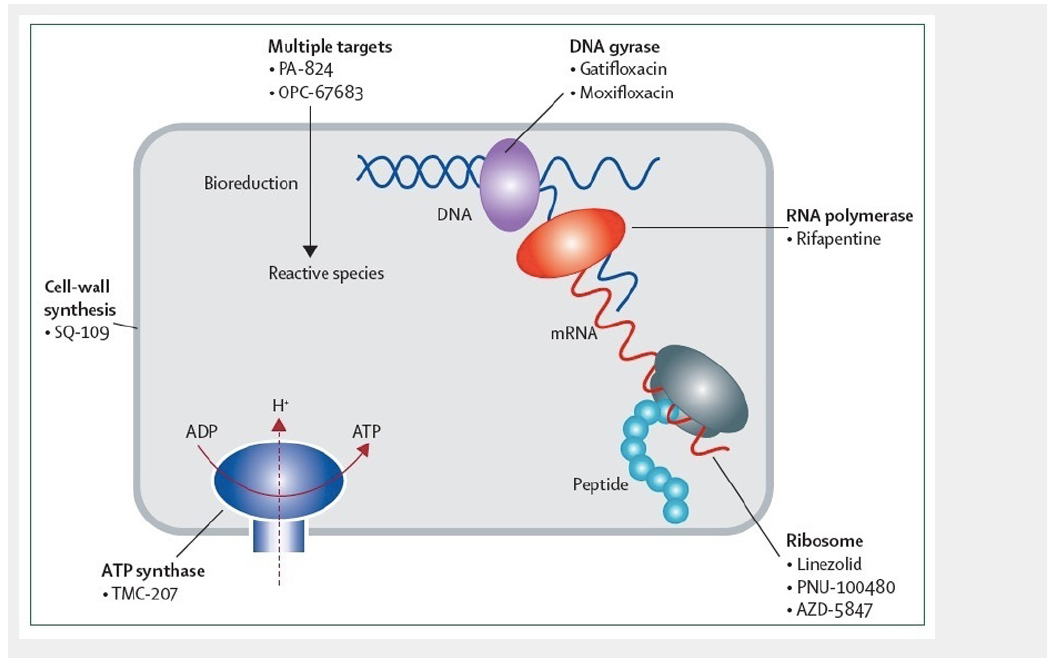
Mechanisms of action of new compounds in clinical development for tuberculosis. (From [51]: Ma Z, Lienhardt C, McIlleron H, Nunn AJ, Wang X. Global tuberculosis drug development pipeline: the need and the reality. Lancet. 2010;375(9731):2100–9. Copyright 2012, with permission from Elsevier, Oxford, UK.)